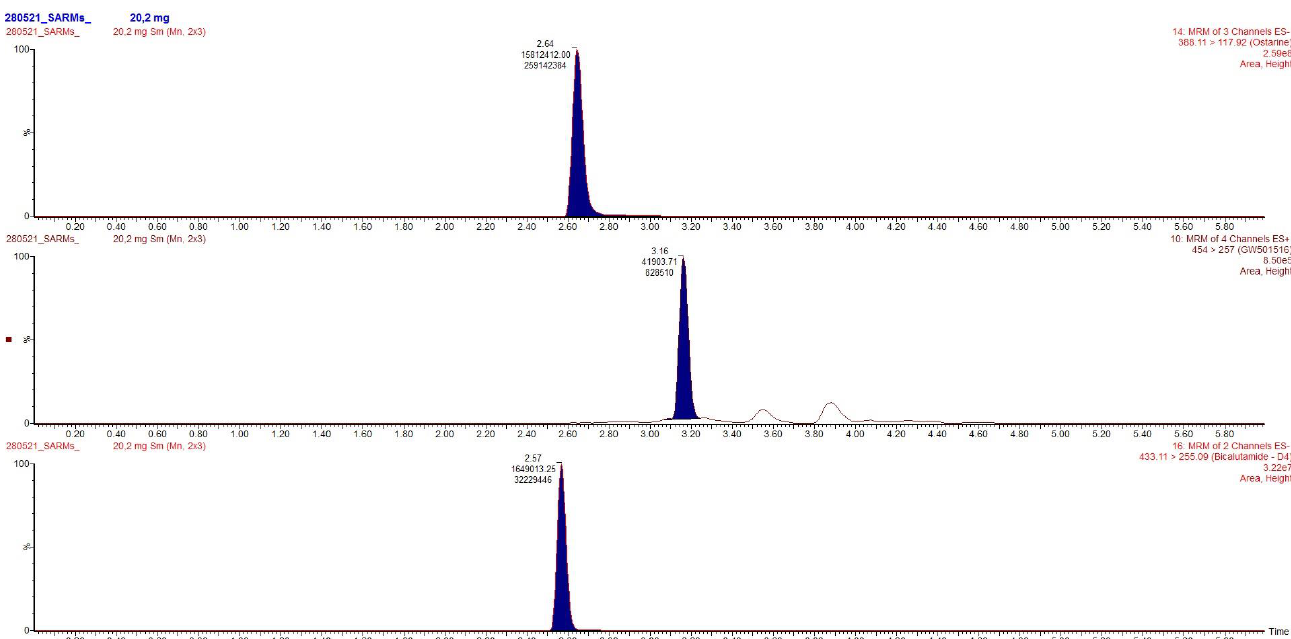
Figure 4. Chromatogram obtained after extraction of the hair. From top to bottom: ostarine (1105 pg/mg), cardarine (146 pg/mg) and the internal standard.